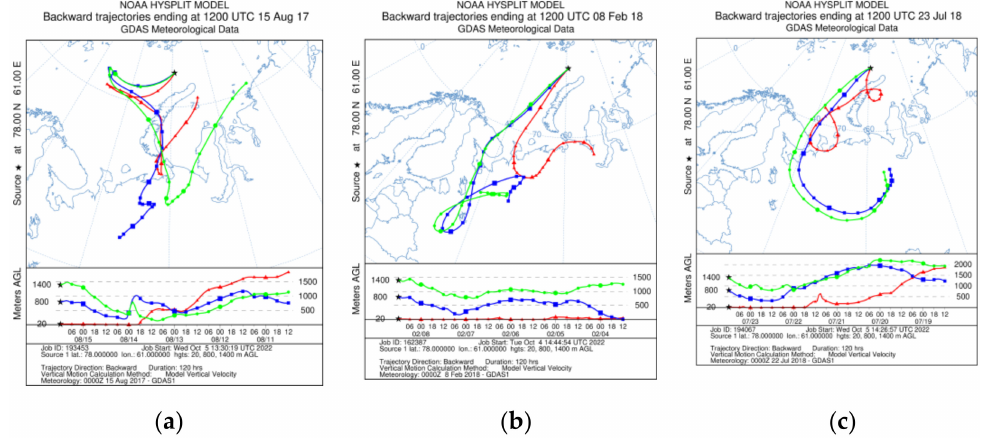
Figure 9. Typical backward trajectories by month: ( a ) in August 2017, ( b ) in February 2018 and ( c ) July 2018.